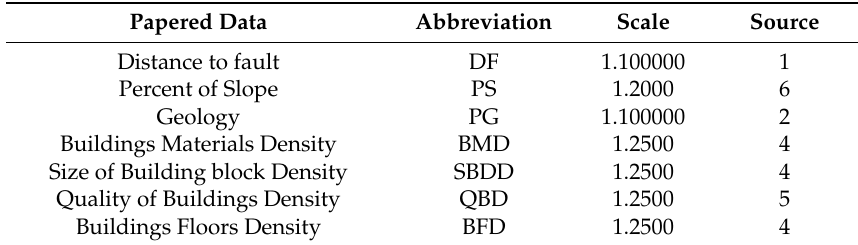
Table 3. The acquired data and the stakeholder